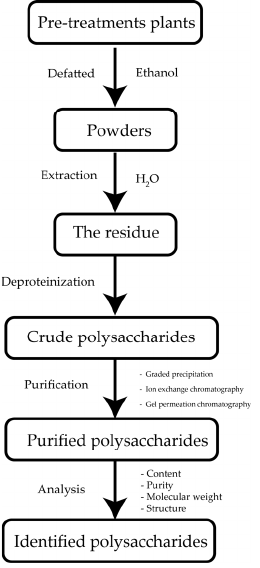
Figure 3. Isolation and purification of polysaccharides from